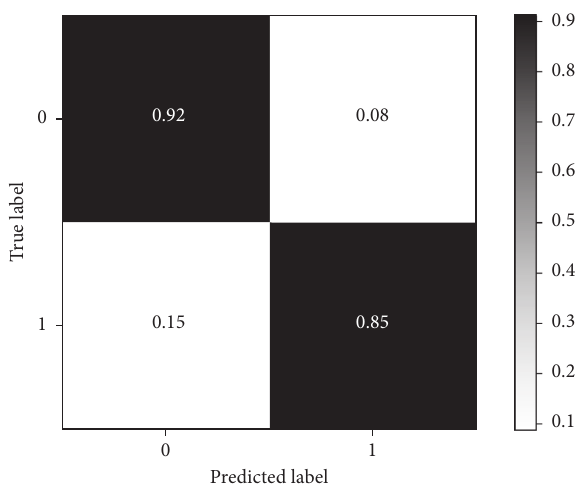
Figure 2: Confusion matrix for testing data using DT model.